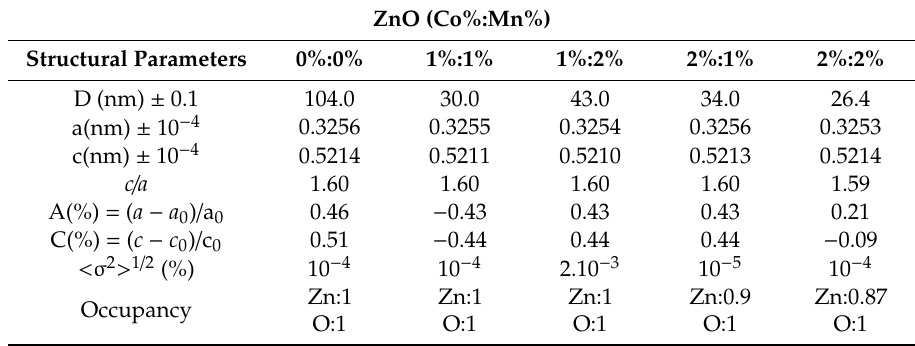
Table 1. Mean grain size values (D), perfect crystal parameters ( a 0 , c 0 ) of ZnO and ( a , c ) of (Co%, Mn%) co-doped ZnO samples, and ( σ 2 ) 1 / 2 is the rate of micro deformation. ZnO (Co%:Mn%) Structural Parameters